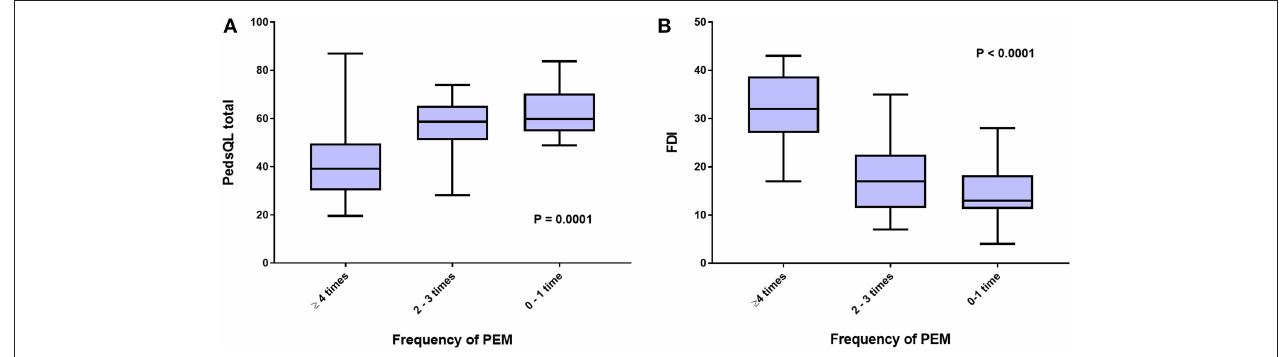
FIGURE 2 | HRQOL measured by (A) , Peds QL total score, and (B) , FDI, according to self-reported frequency of post-exertional malaise (PEM) in the preceding 2 weeks.